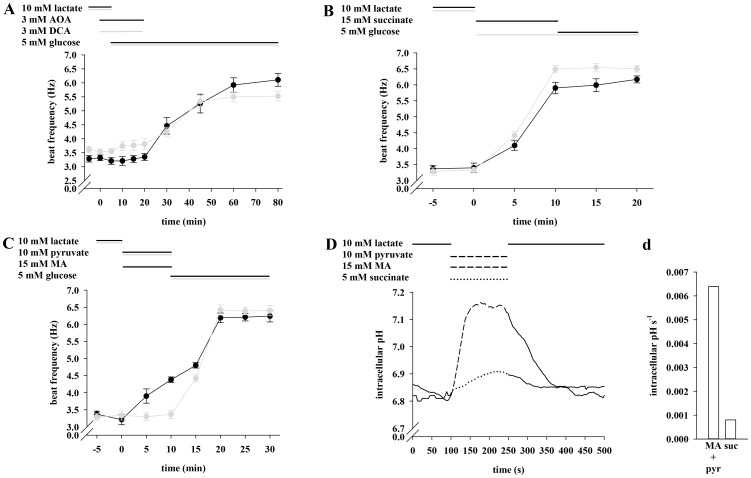
The glucose-mediated acceleration of sperm beat frequency involves mitochondria and can be mimicked by succinate.
A, After a 5 min pre-run of either 3 mM AOA (black plot) or 3 mM DCA (grey plot) in buffer HS containing 10 mM lactate, sperm were perifused with the respective inhibitor in the presence of 5 mM glucose for 15 min. AOA/DCA were washed out for a subsequent period of 60 min with HS buffer supplemented with 5 mM glucose. Compared to t  = 0 min, the frequency values significantly increased at t ≥30 min (***p<0.001). B, After initial perifusion with 10 mM lactate, sperm were first stimulated for 10 min with 5 mM succinate and then for another 10 min with 5 mM glucose (black plot). For control measurements (gray plot), sperm were stimulated for 20 min with only glucose. Compared to t  = 0 min, the frequency values significantly increased at t  = 5 min (**p<0.05) and at t ≥10 min (***p<0.001) in both approaches. C, Treatment with 10 mM lactate was followed by a 10-min perifusion with 10 mM pyruvate and 15 mM MA simultaneously present in the buffer and a subsequent stimulation with 5 mM glucose for further 20 min (black plot). During the control measurements (gray plot), sperm were treated the same way except for omitting MA. Co-application lead to a significant increase of flagellar beat at t  = 5 min with **p<0.05 and at t ≥10 min with ***p<0.001. In the control significance of ***p<0.001 was reaches at t ≥15 min. Shown are mean values±s.e. of 38 cells of 3 animals. D, Sperm were exposed for 100 s to 10 mM lactate before being stimulated for 150 s with 10 mM pyruvate +15 mM MA (dashed line) or 5 mM succinate (dotted line). Thereafter, cells were allowed to recover for 200 s to initial values. The plots of A to D represent mean values±s.e. of 25–33 cells of 3 animals. The graphs in d show mean values of 30–35 cells of 3 animals and mean slopes were analyzed as described in the penultimate figure legend.